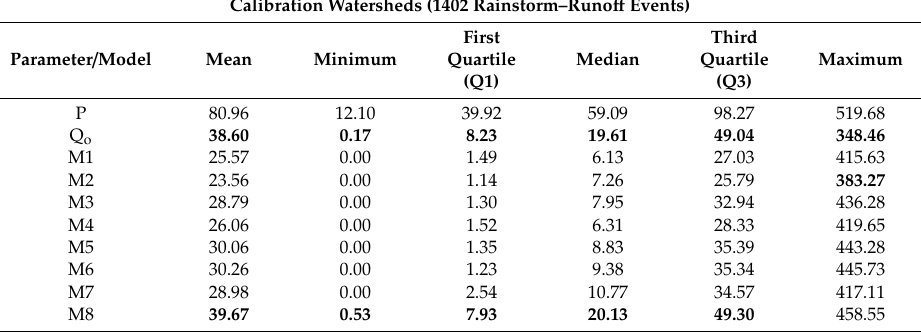
Table 3. Summary statistic of rainfall (P), observed runo ff (Q o ), and modeled runo ff (M1–M8) in the calibration and validation